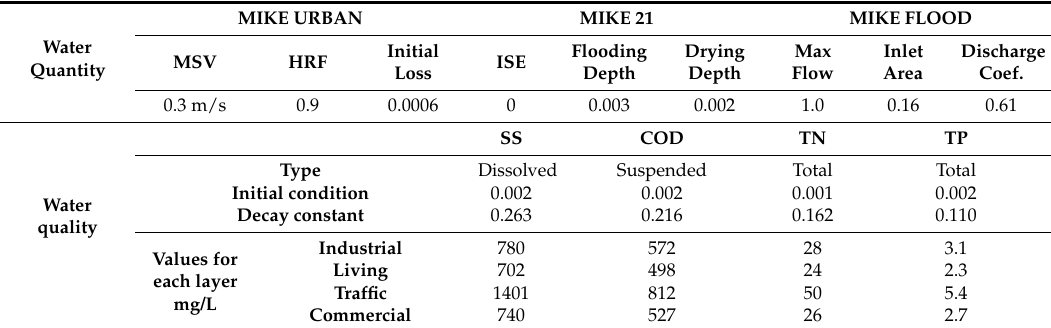
Table 1. Parameters of calibration results of the model.